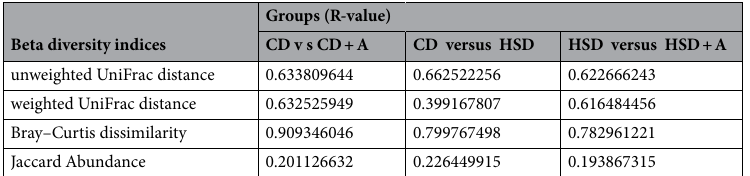
Table 4. Short term effect of high-salt diet (4% in chow) followed by Amoxicillin treatment on beta diversity. CD: Standard—chow diet for 3 weeks; CD: Standard—chow diet for 2 weeks; CD + A.: Standard—chow diet for 3 weeks and underwent Amoxicillin treatment last week; HSD: High-salt diet for 3 weeks; HFD + A.: High-salt diet for 3 weeks and underwent Amoxicillin treatment last